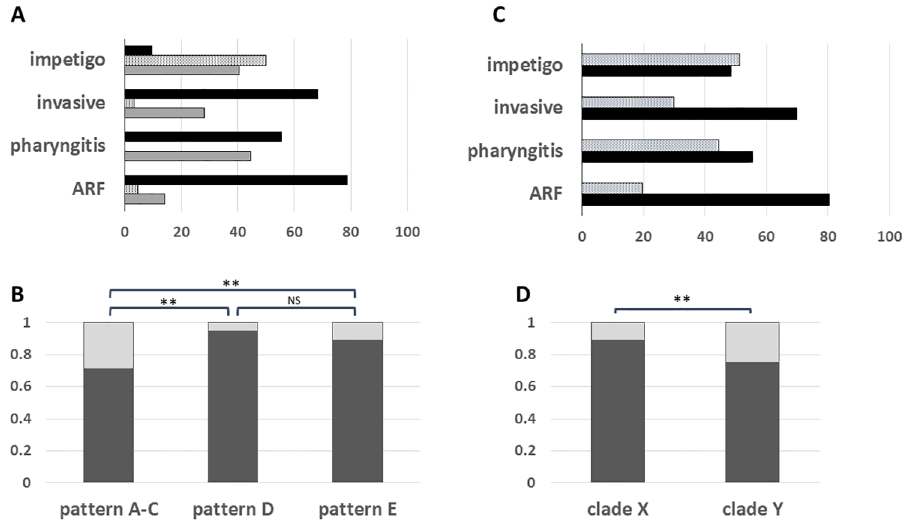
Fig 1. Study sample composition and SpeB production according to emm pattern group and emm clade. All GAS isolates under study were assignedto an emm pattern group and emm clade, basedon their emm type. Panels A and C: The emm pattern (panelA: pattern A-C, black; pattern D, speckled; pattern E, gray) and clade (panelC: clade X, speckled; clade Y, black) distributions (%) of each disease-defined subset of GAS strains is shown. Panels B and D: The fractional distributionsof SpeB producers(dark gray) and SpeB non-producers (light gray) are plotted. SpeB phenotype is basedon the Columbia-SM agar assay. The statistical significanceof differences was tested using the Fisher exact test (2-tailed; ** for p < 0.01).